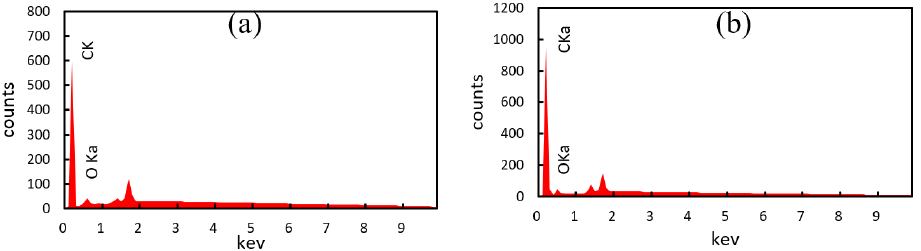
Figure 4. EDS surface elemental analysis results for ( a ) untreated carbon felt and ( b ) carbon felt after attachment treatment. Table 1. EDS Surface Element Analysis Results Comparison.